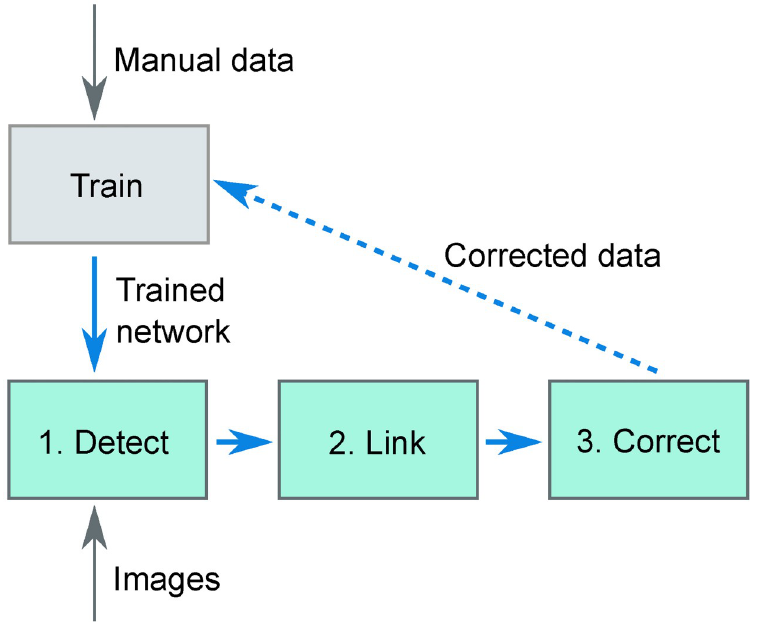
Fig 2. Overview of the tracking software. Using ground-truth data of nucleus locations in microscopy images (obtained from manual detection) a convolutional neural network is trained. This trained network is then used to detect (step 1) cells in new images. The detections are then linked over time (step 2), after which the user manually corrects the output with the help of an error checker (step 3). In principle, the manually corrected data can be used as additional ground-truth data to improve the training of the convolutional neural network, leading to an efficient, iterative improvement in performance of the convolutional neural network (dashed line).